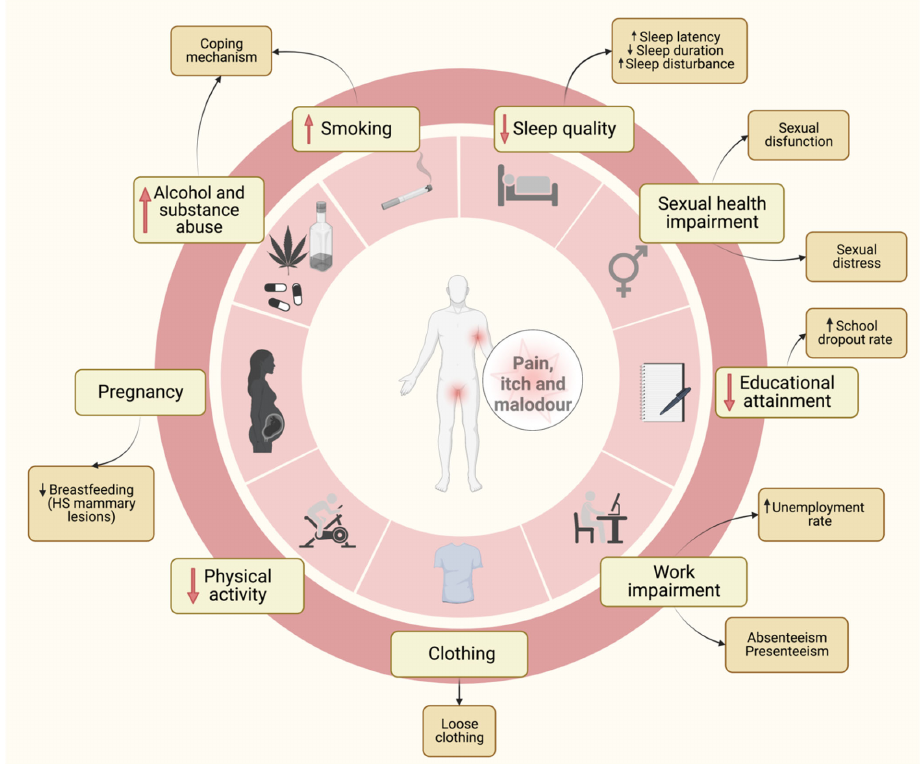
Figure 2. Main habits influenced by HS. For a detailed explanation, see the text. Image created with BioRender.com. Abbreviation: HS, hidradenitis suppurativa. Information extracted from